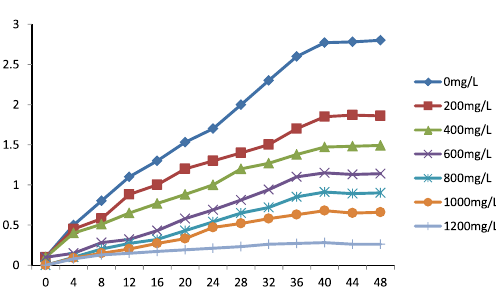
) on P. aeruginosa DM1 growth 3 2